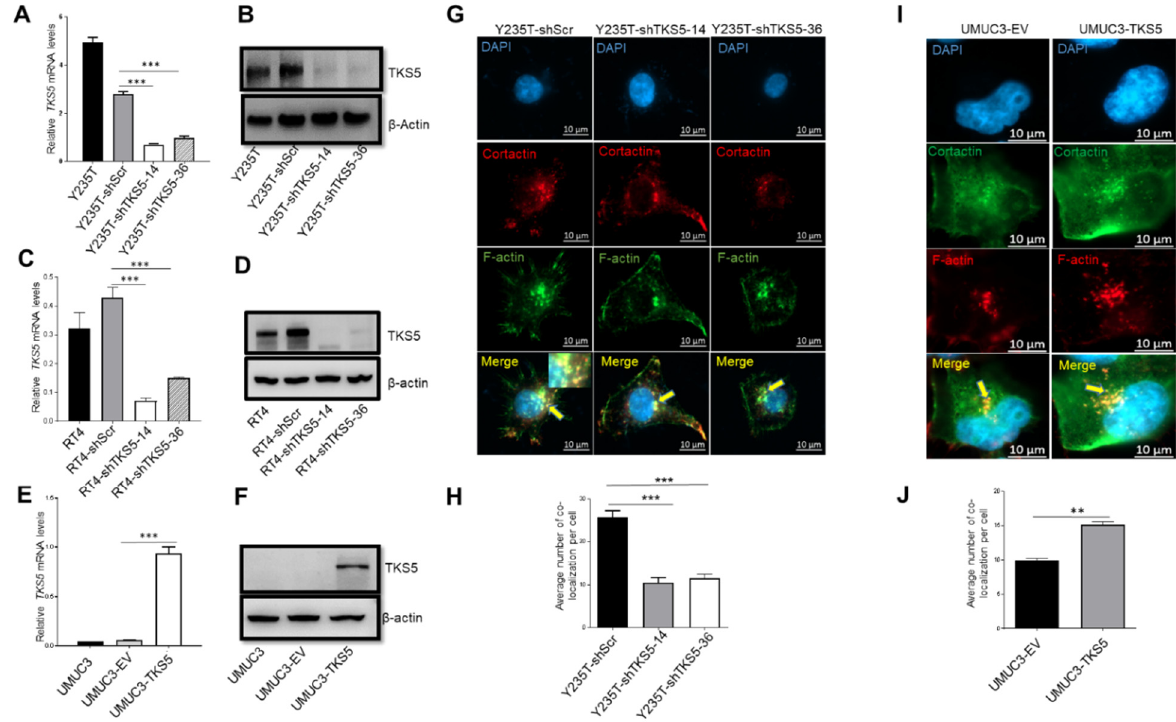
Figure 6. TKS5 influences colocalisation of cortactin with F-actin in Y235T and UMUC3 cells. ( A – F ) TKS5-knockdown efficiency in ( A , B ) Y235T, ( C , D ) RT4 and ( E , F ) UMUC3 cells. ( A , C , E ) RT-qPCR experiments showing relative TKS5 mRNA levels. In Y235T and RT4 cells, we determined the relative TKS5 expression in parental Y235T cells, Y235T cells with a control, scrambled shRNA (Y235T-shScr) and TKS5-knockdown cells (shTKS5-14 and shTKS5-36, respectively). In UMUC3, we determined the TKS5 expression in parental cells, empty-vector-containing cells (UMUC3-EV) and TKS5 expression vector-containing cells (UMUC3-TKS5). ( B , D , F ) TKS5 protein levels as determined via Western blot. ( G , I ) We visualised the cortactin/F-actin colocalisation with a cortactin-specific antibody in combination with phalloidin staining (green). Yellow dots indicate colocalisation of F-actin and cortactin (red), as indicated by yellow arrows. Blue colour indicates DAPI. ( H , J ) Quantitation of cortactin/F-actin signals in Y235T and UMUC3 cells with indicated genotypes. We repeated all the experiments three times. We used Student’s t -test and analysis of variance (ANOVA) to analyse the statistical significance. Error bars represents mean +/ − SD (** p < 0.01; *** p < 0.001).